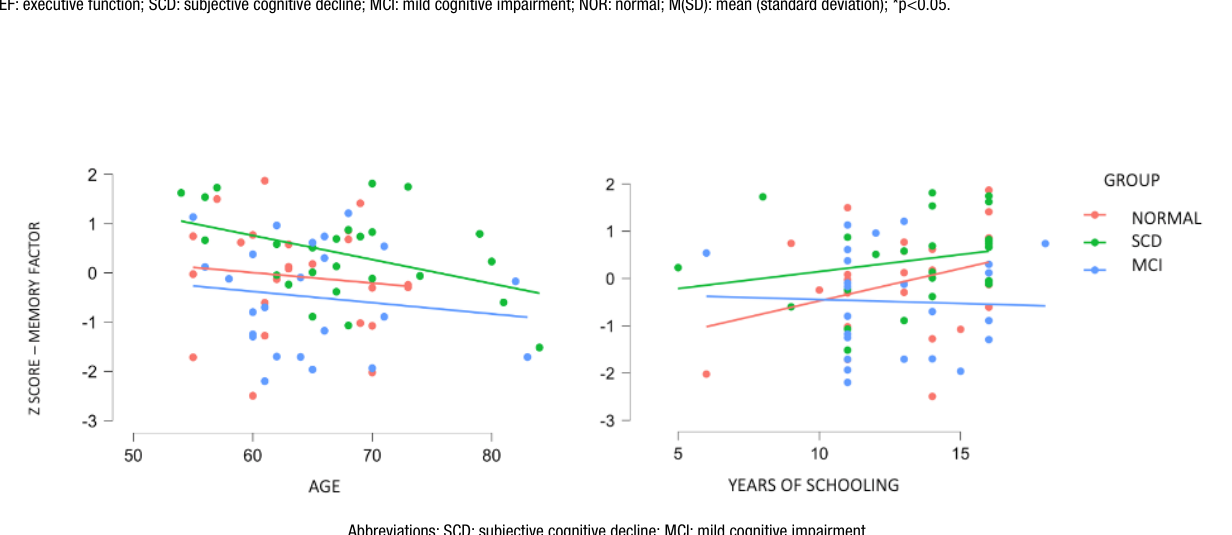
Figure 1. Descriptive plots of memory factor in pre-clinical groups by age and years of